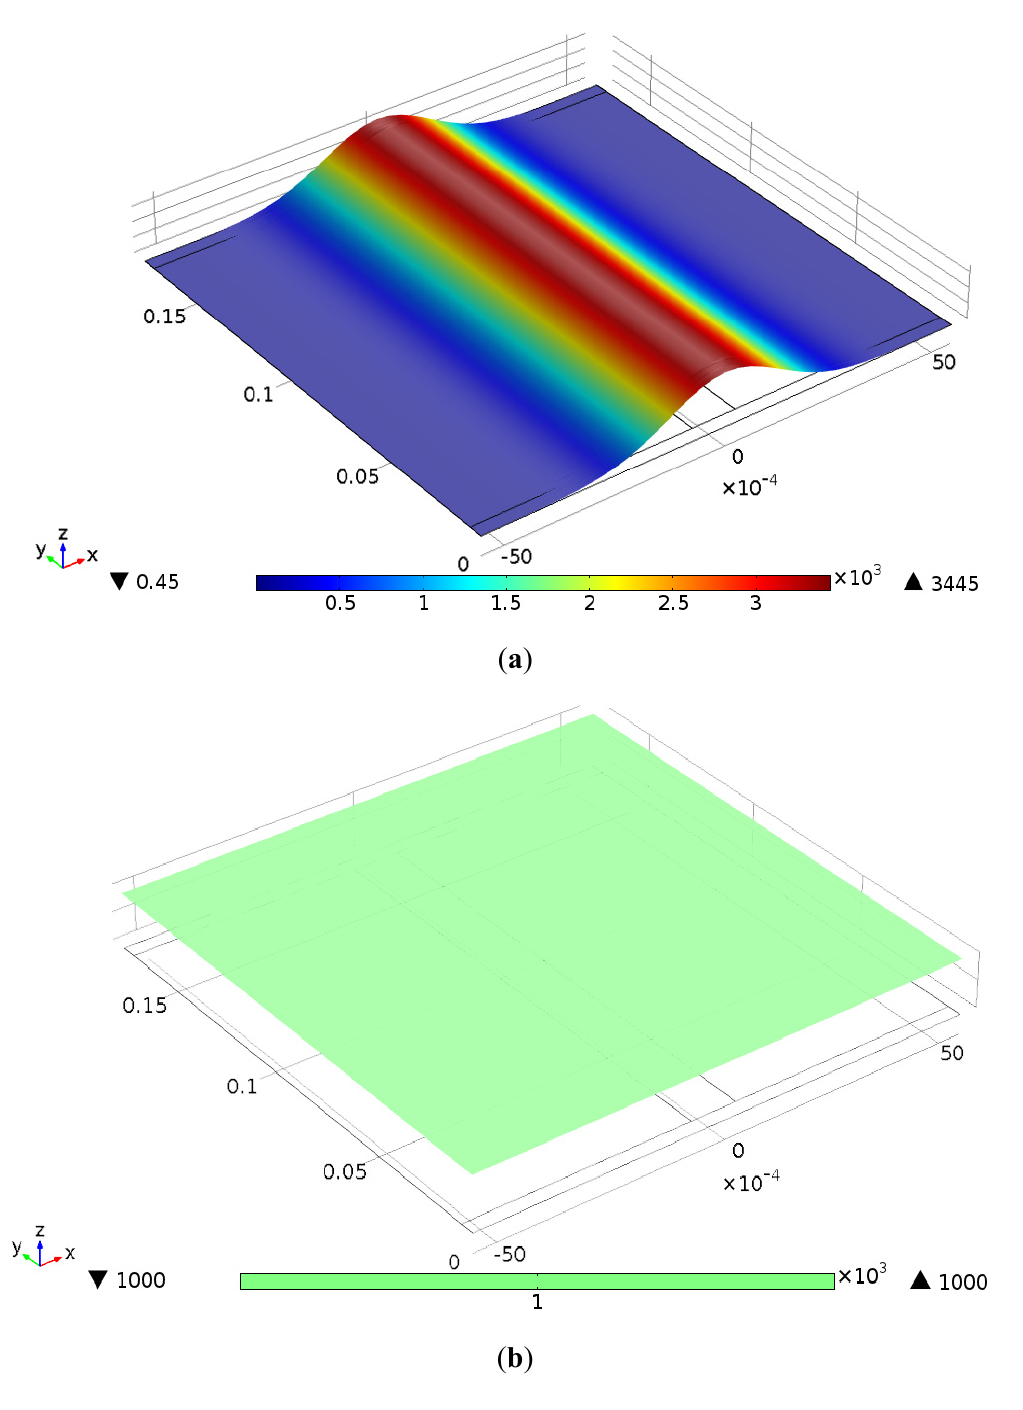
Figure 6. Simulated illumination distribution for: ( a ) Profile 3; ( b ) Uniform illumination distribution, x-axis is the busbar direction (m) and y-axis is the finger direction